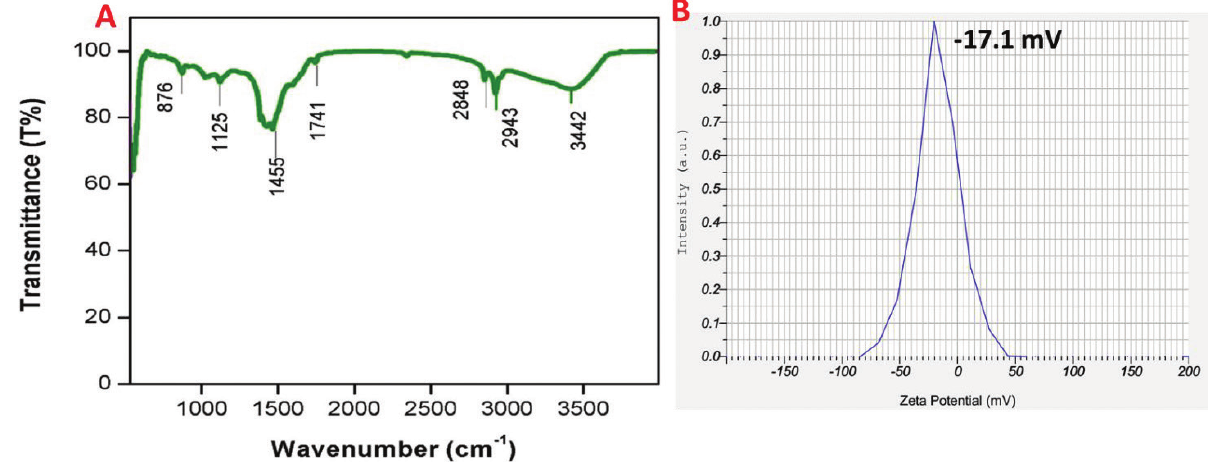
Figure 4: FT-IR spectrums (a) and Zeta potential (b) of ZnO NPs.